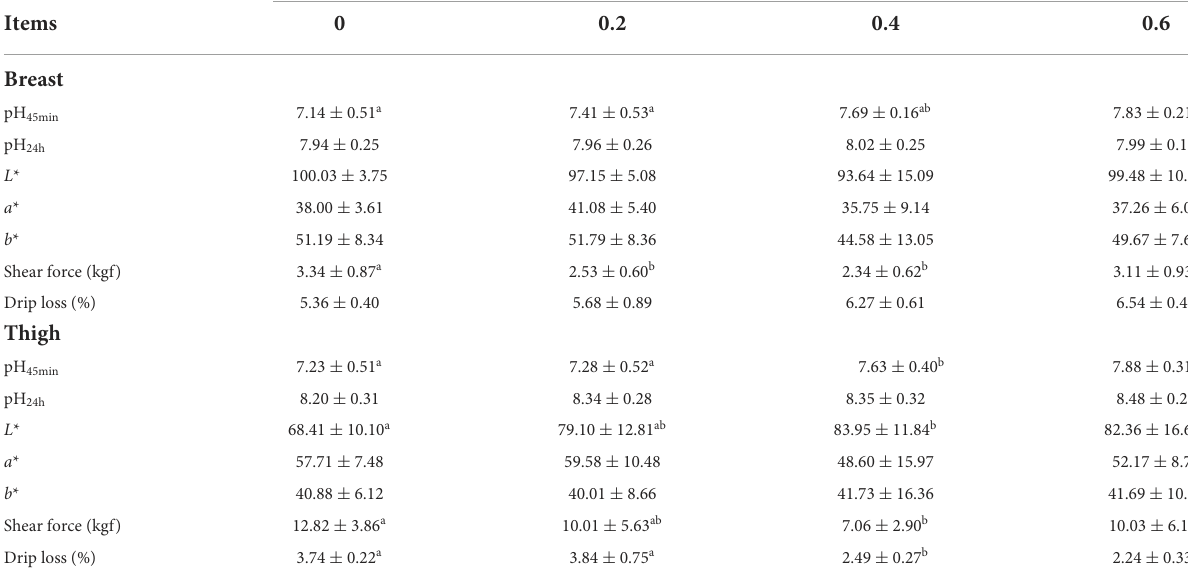
TABLE 3 Effects of dietary quercetin on meat quality in AA broilers.